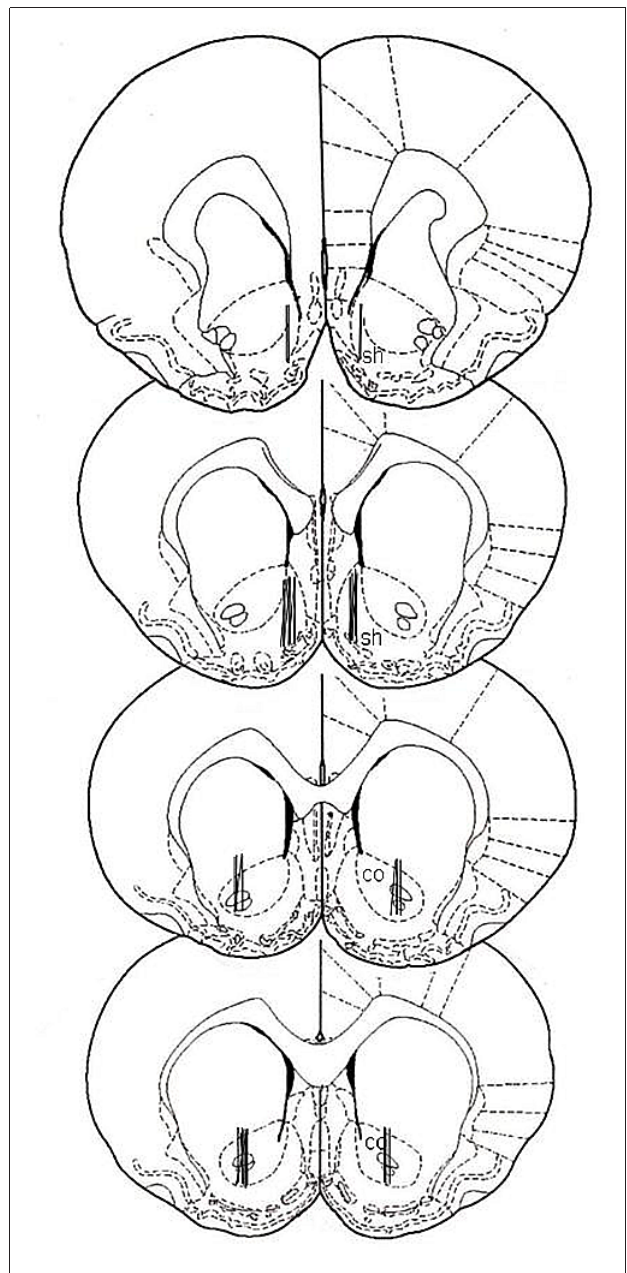
FIGURE 1 | Localization of dialysis probes (dialysis portion) within the nucleus accumbens (NAc) shell and core according to Paxinos and Watson (1998). sh, shell; co,